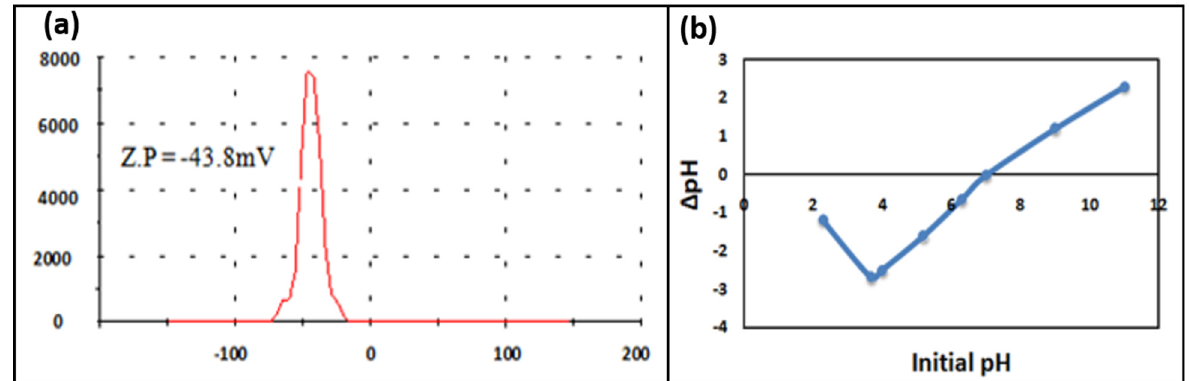
Figure 6. ( a ) Surface charge determination via zeta potential; ( b ) the plot of Δ pH versus pH initial for the determination of pHzpc. the determination of